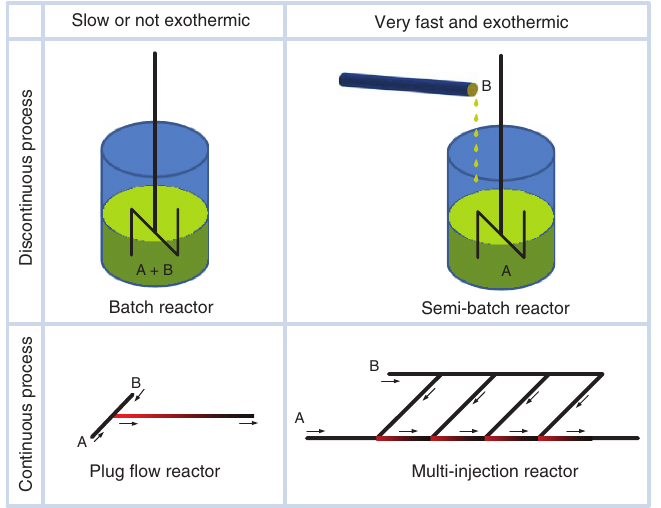
Figure 1 Using multiple injection points for improved thermal control during continuous processing of quasi-instantaneous exothermic reactions.